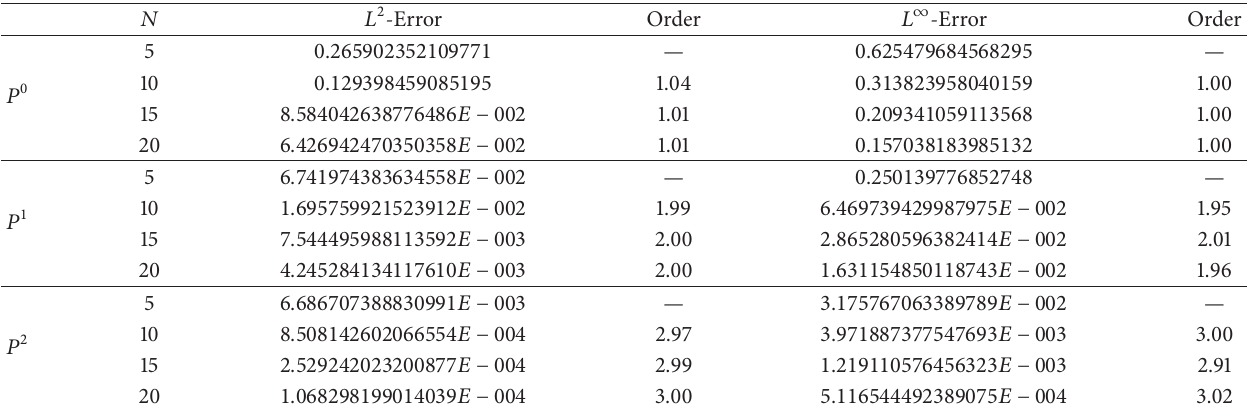
Table 3: Spatial accuracy test for the fractional order equation with the forcing term (42). 𝛼 = 0.3 , 𝑀 = 10 4 , 𝑇 = 1 . 𝑁 𝐿 2 -Error